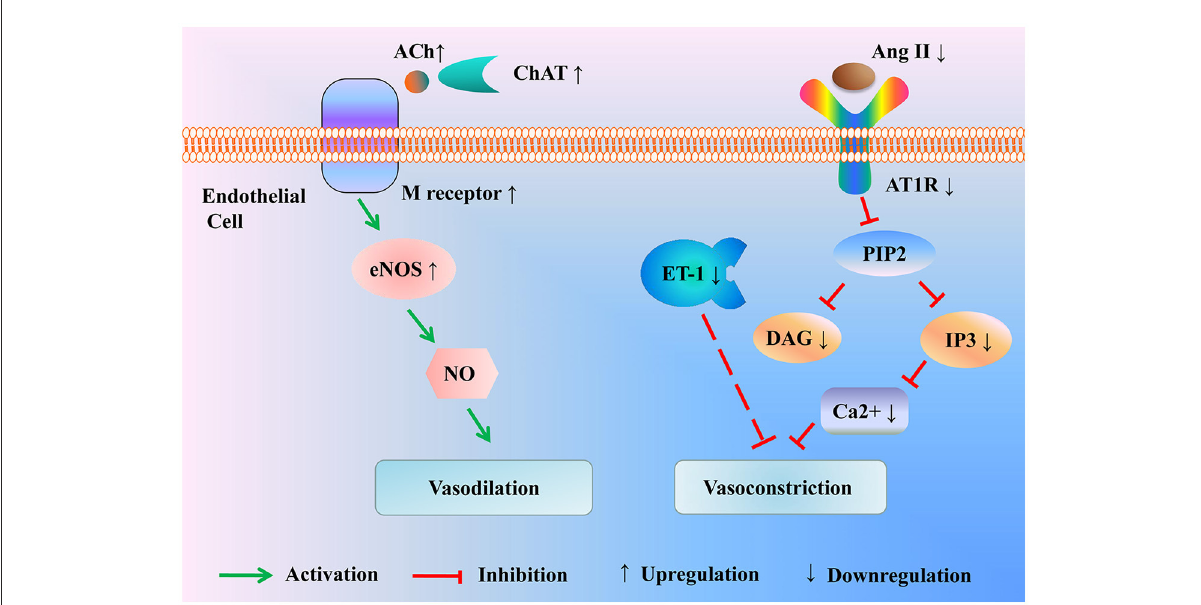
FIGURE2 Modulation of the vasoactive substance by acupuncture for treating ischemic stroke. Acupuncture enhances the expression of ChAT to promote the activation of the ACh/eNOS signal pathway, resulting in vasodilation. Besides, acupuncture drops the level of Ang II and AT1R to inhibit the activation of the IP3 signal pathway, thus mitigating vasoconstriction. In the meantime, acupuncture alleviates the production of vasoconstrictor factor ET-1. ACh, Acetylcholine; ChAT, choline acetyltransferase; eNOS, endothelial nitric oxide synthase; Ang II, Angiotensin II; AT1R, Ang II type 1 receptor; PIP2, phosphatidylinositol (4,5)-bisphosphate; DAG, diacylglycerol; IP3, inositol triphosphate; ET-1, endothelin-1.